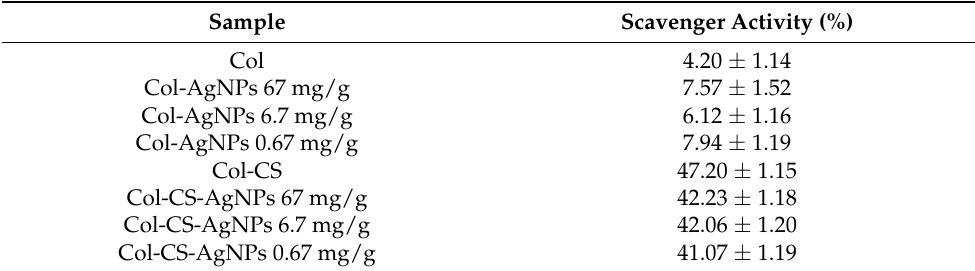
Table 2. Antioxidant activity of collagen hydrogels loaded with silver nanoparticles and Cannabis sativa oil extract calculated as the inhibition percentage of DPPH